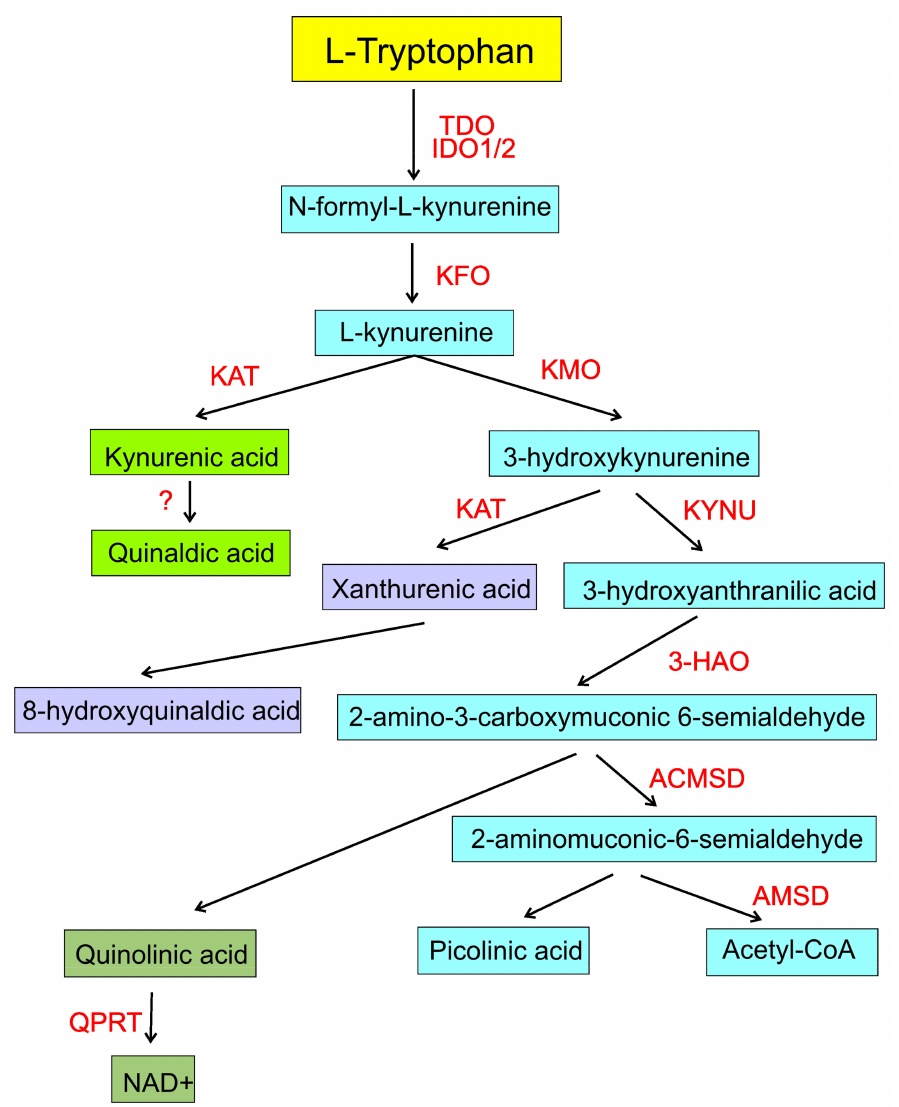
Figure 2. The kynurenine pathway of L -tryptophan metabolism. The key enzymes of the pathway are in red. Different colors in the boxes with metabolites are to distinguish different subpathways only. Some reactions proceed nonenzymatically. NAD+, oxidized nicotinamide adenine dinu- cleotide; TDO, tryptophan 2,3-dioxygenase IDO1/2, indoleamine 2,3-dioxygenase 1 or 2; KAT, kynurenine aminotransferases; KMO, kynurenine 3-monooxygenase; KYNU, kynureninase; 3-HAO, 3-hydroxyanthranilic acid 3,4-dioxygenase; ACMSD, aminocarboxymuconate-semialdehyde decar- boxylase; AMSD, 2-aminomuconic semialdehyde dehydrogenase; QPRT, quinolinic acid phosphori-